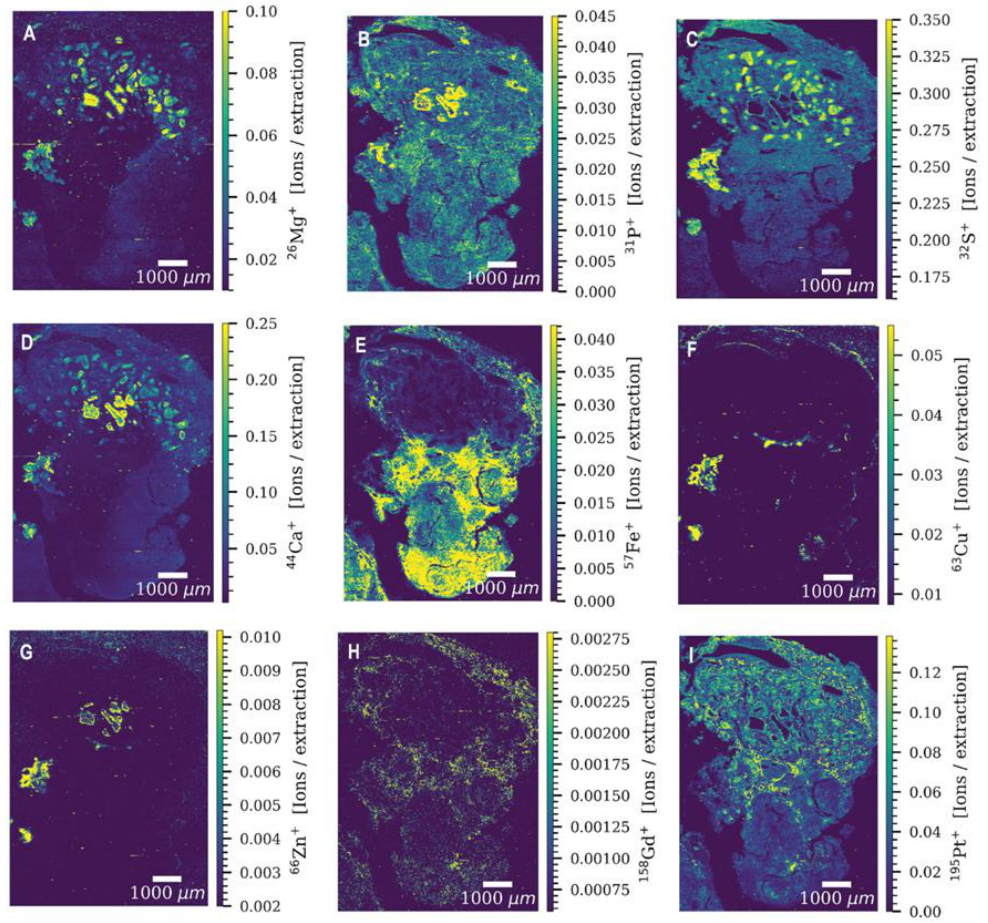
Figure 2. Signal intensity maps of ( A ) Mg, ( B ) P, ( C ) S, ( D ) Ca, ( E ) Fe, ( F ) Cu, ( G ) Zn, ( H ) Gd, and ( I ) Pt in a germ cell tumor tissue section of a patient obtained by LA-ICP-TOFMS imaging. The parallel line scans overlap one another by 10 µm. Reprinted with permission from [22]. Copy right year: 2020, copyright owner: Oxford University Press.